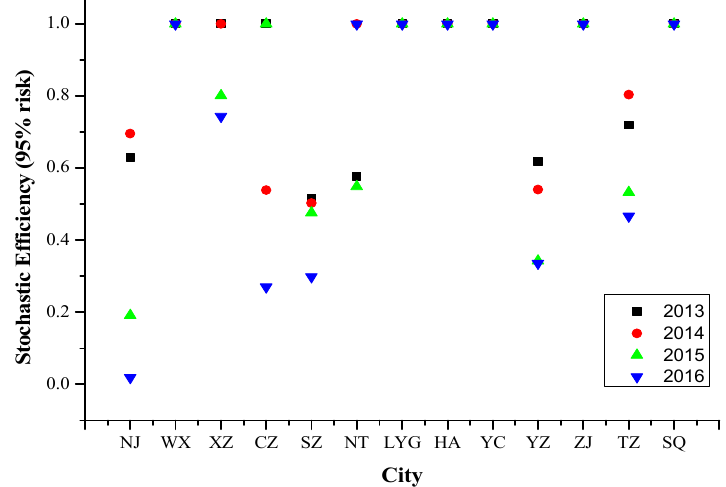
Figure 1. Stochastic efficiency values of 13 cities in Jiangsu Province at 95% risk level from 2013 to 2016. Abbreviations: Nanjing (NJ), Wuxi (WX), Xuzhou (XZ), Changzhou (CZ), Suzhou (SZ), Nantong (NT), Lianyungang (LYG), Huai’an (HA), Yancheng (YC), Yangzhou (YZ), Zhenjiang (ZJ), Taizhou (TZ), Suqian (SQ).